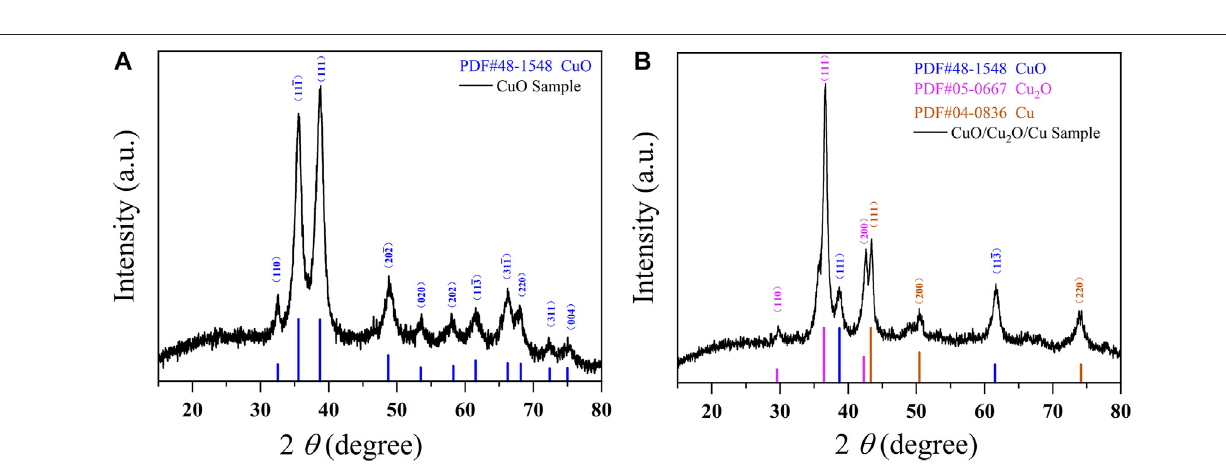
Frontiers in Chemistry |